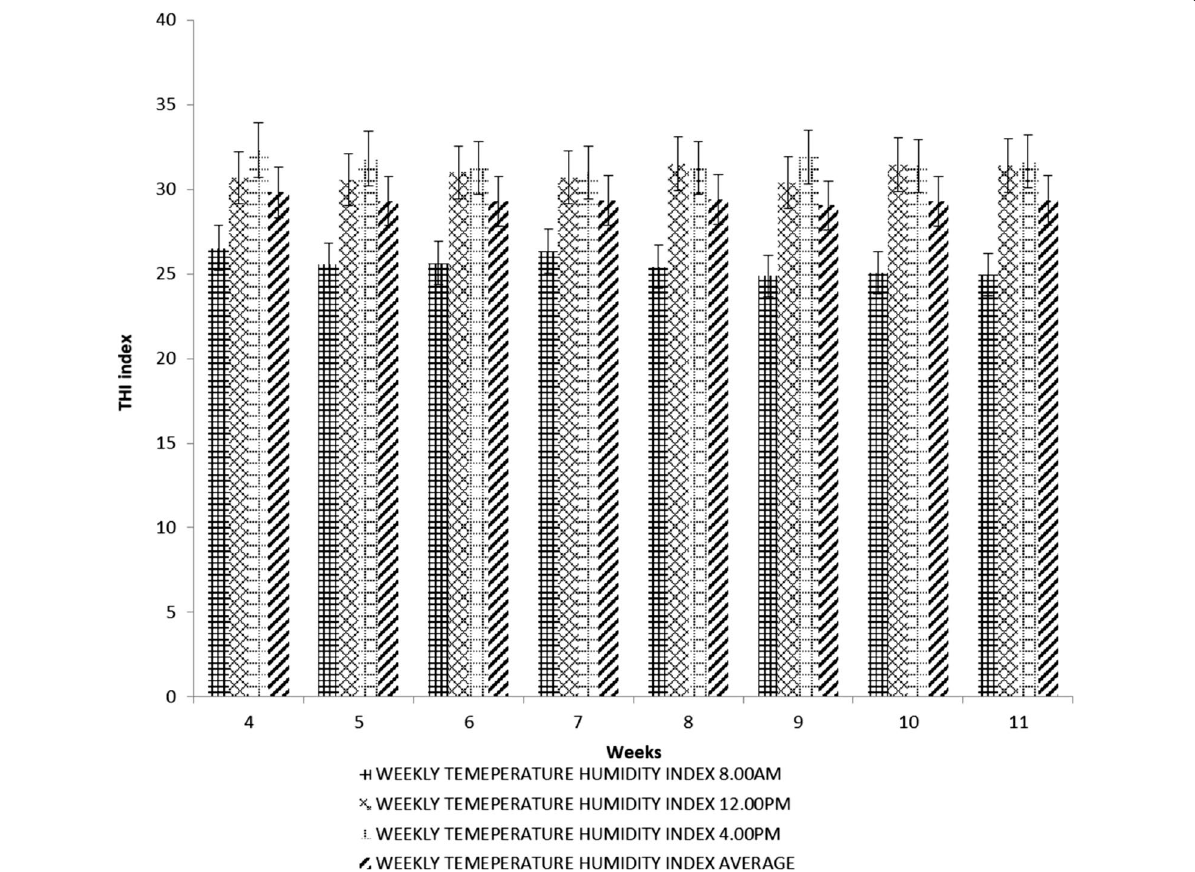
Fig. 1 Temperature-humidity index (THI) patterns during the weeks of